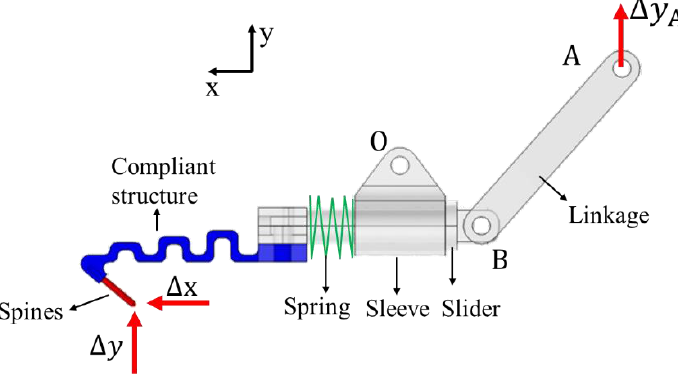
Figure 4. Rigid-flexible coupling simulation model of spines single foot.